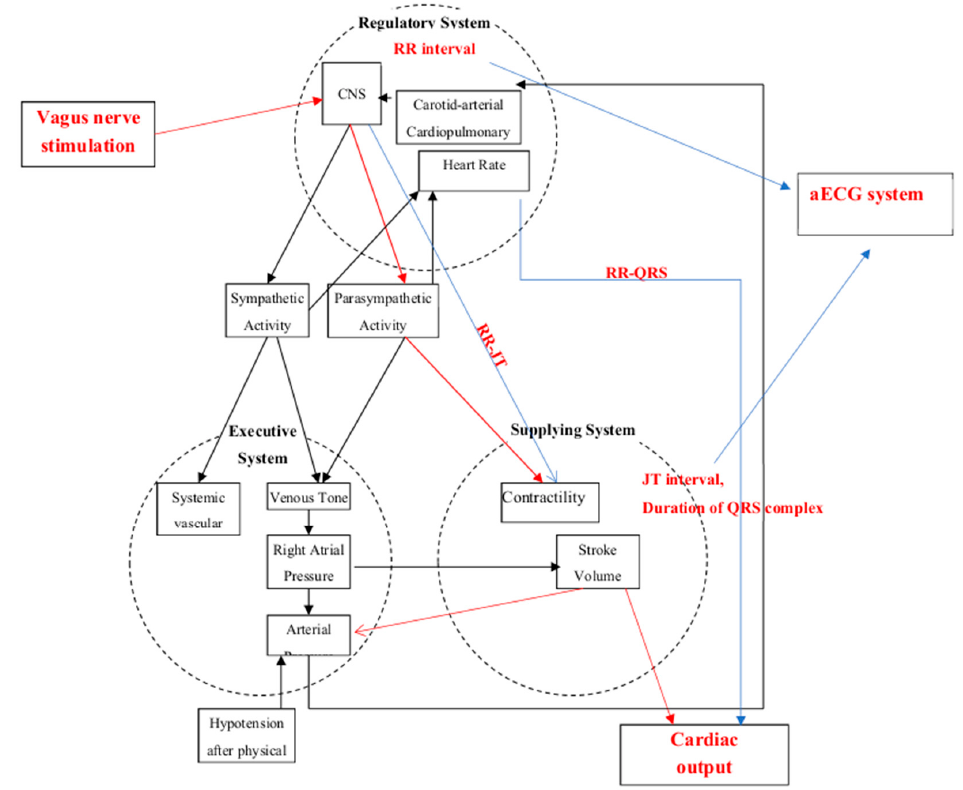
Figure 2. Baroreceptor control loops in the context of the model of integral evaluation.